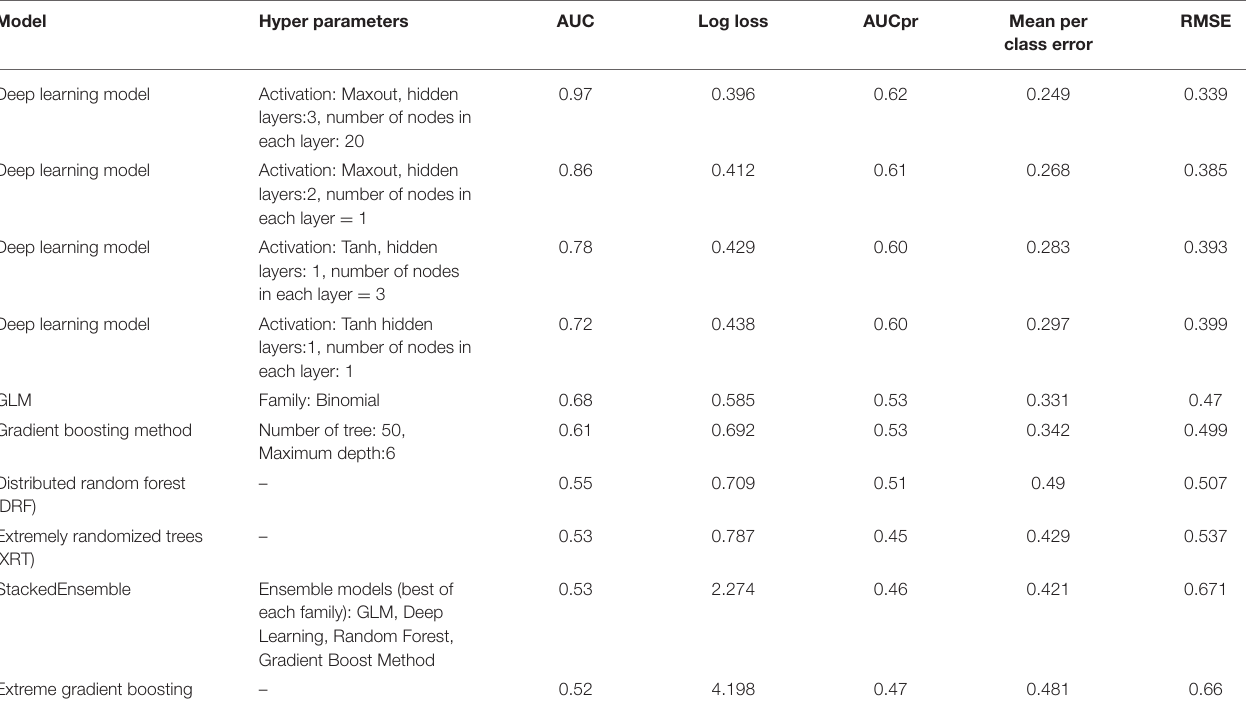
TABLE 3 | Performance of the different learning models in the training